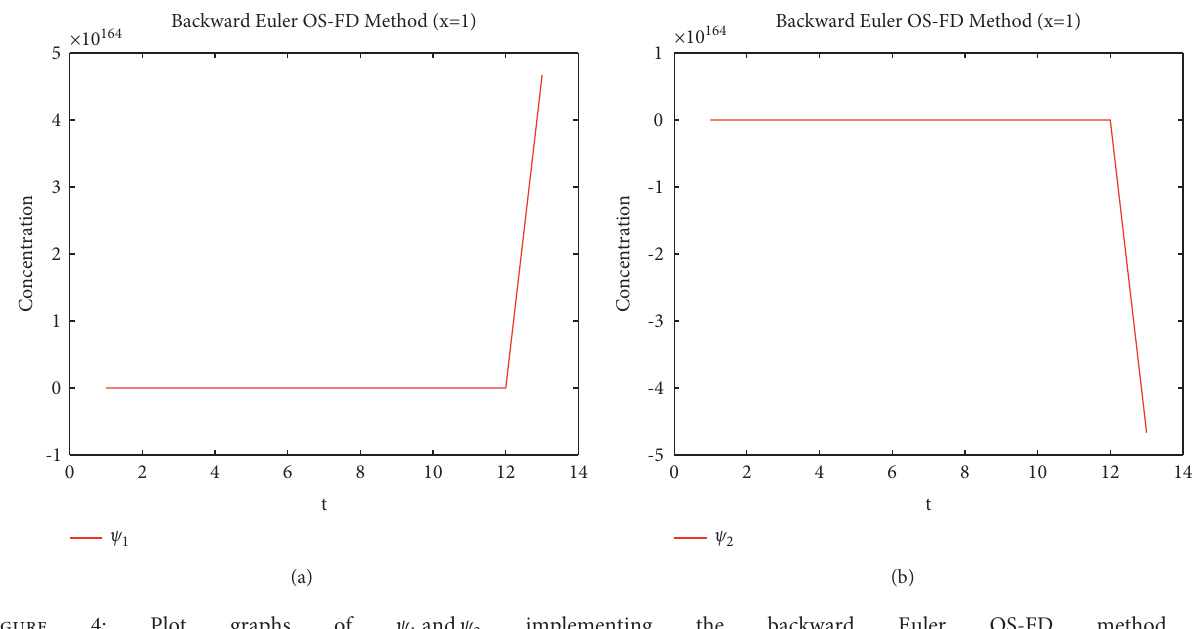
. (b) Plot graph of ψ 1